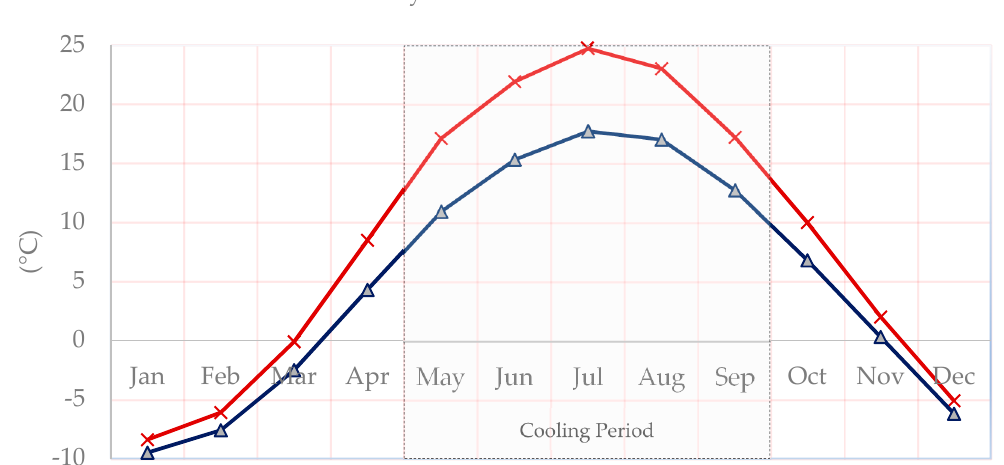
Figure 3. Annual temperature profile of the mine site location. Table 3. Properties of the selected mining operation.